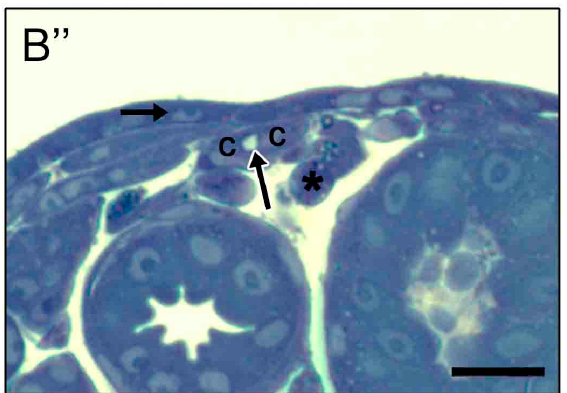
Figure 5. Cardioblasts at the midline are capable of developing an open lumen between contralateral cells. In stage 17 wildtype embryos (A) , contralateral CBs (“c”) are present at the dorsal midline and enclose a lumen (arrow). Dorsal to the heart is a thick and continuous ectoderm (horizontal arrow) and few if any amnioserosa cells remain ventrally (asterisks). In src42A E1 mutants, the ectoderm layer is thin and variable (horizontal arrow in B–B” ) and amnioserosa cells persist at or near the midline (asterisks; for some cells marked with an asterisks, identity is uncertain). The CBs are not consistently present at the midline (e.g., c? in B’ ); however, when two contralateral CBs are present, a small lumen often forms (arrow in B” ). Dorsal at top. Calibration: 10